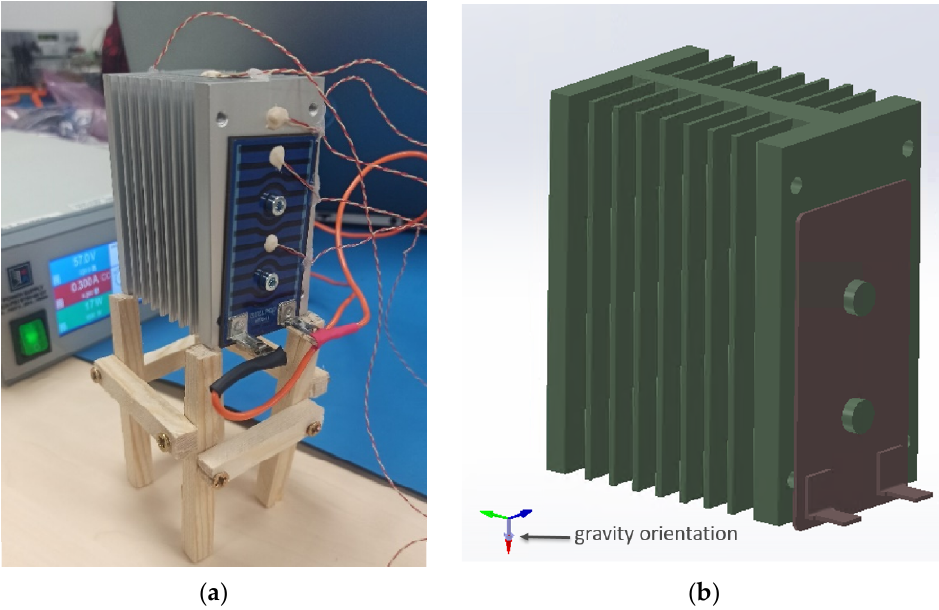
Figure 5. ( a ) Measurement of Setup 2; ( b ) Simulated model of Setup 2 and gravity orientation.